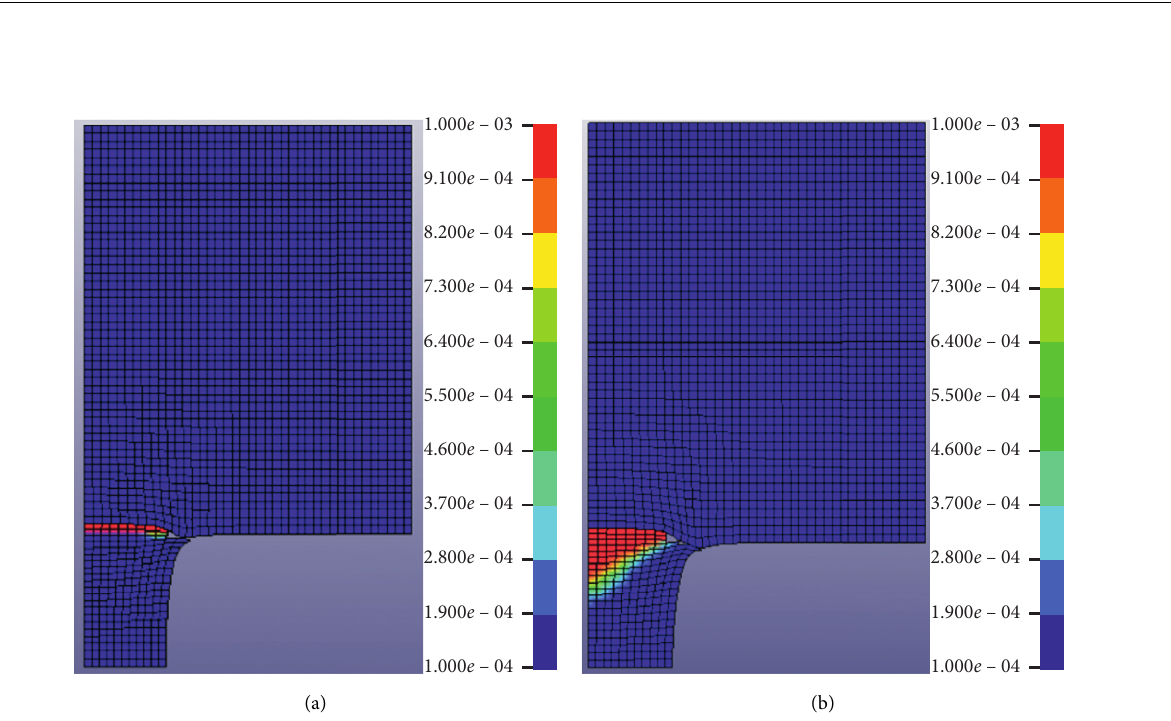
Figure 4: Contour of y (running to 2 μ s). (a) Impact velocity is 1191m s − 1 . (b) Impact velocity is 1532m s − 1